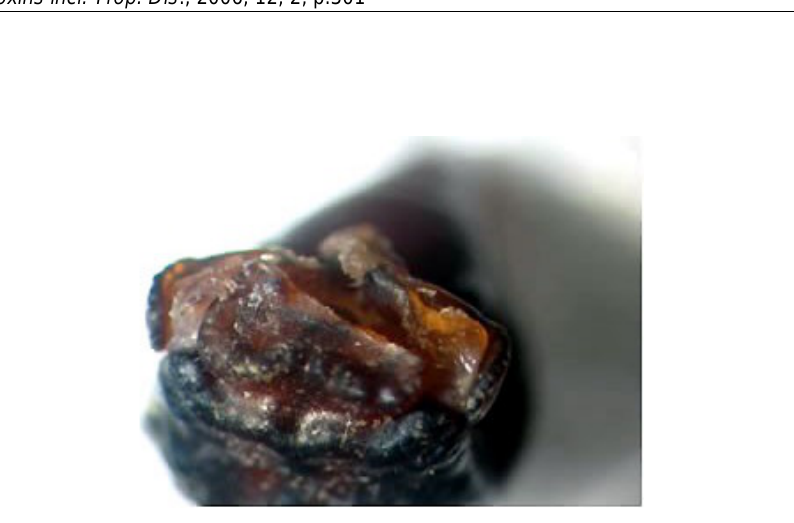
Figure 3: The view of a closed telson (by Ozkan O. et al . J. Venom. Anim. Toxins incl. Trop. Dis ., 2006, 12, 297-309).